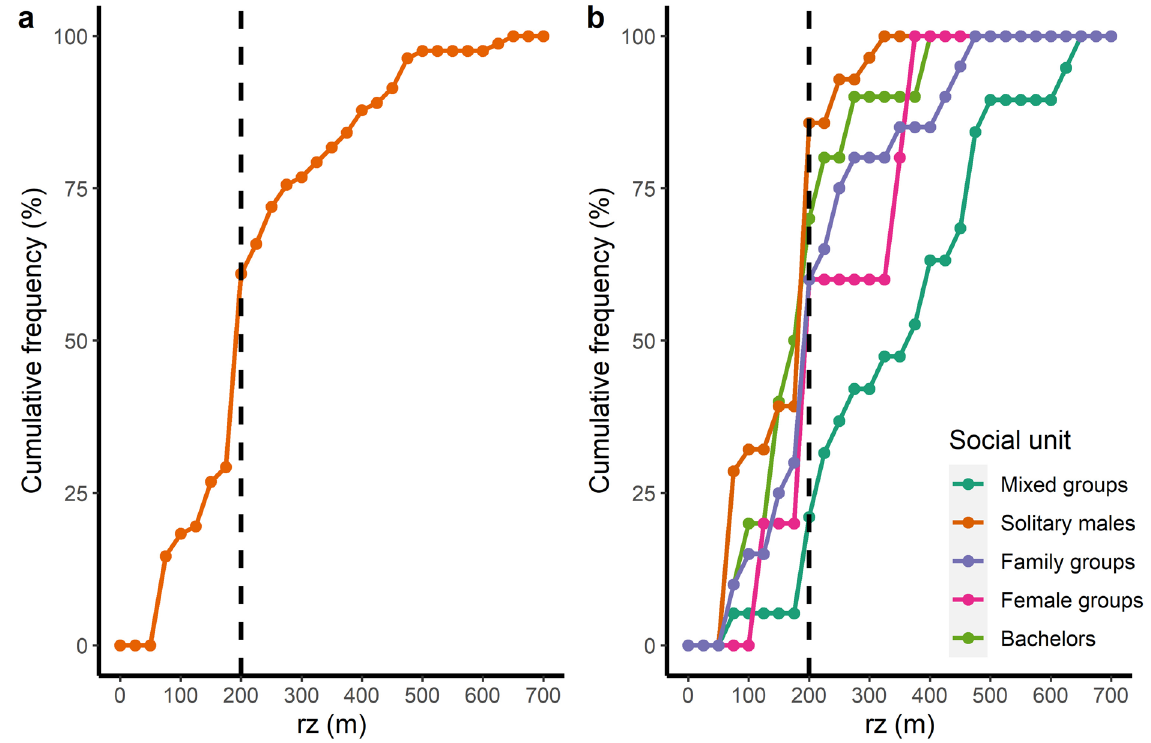
Figure 5. Cumulative frequency of rz for ( a ) all flights, and ( b ) each social unit separately. The dotted vertical lines at 200 m represent a trade-off between flying high enough to minimise flight reactions in the guanaco population under study, while ensuring safe flights and unbiased data, using a Phantom 4 Advanced (a multirotor drone carrying a 20MP